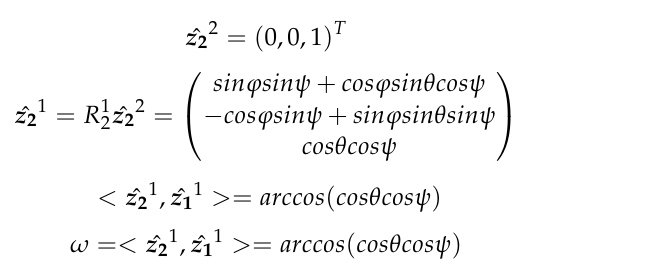
Figure 7. Wrist conversion from 2 DOF to 1 DOF. x 1 y 1 z 1 and x 2 y 2 z 2 are the DH coordinate systems connecting the two links of the elbow joint, respectively. ω is the rotating angle of the elbow joint.